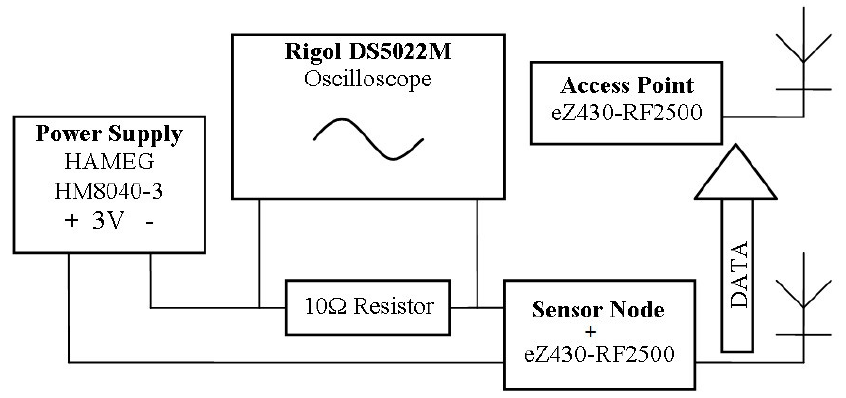
Figure 21. Testing telemonitoring function: ( a ) accuracy of body temperature measurements (°C);